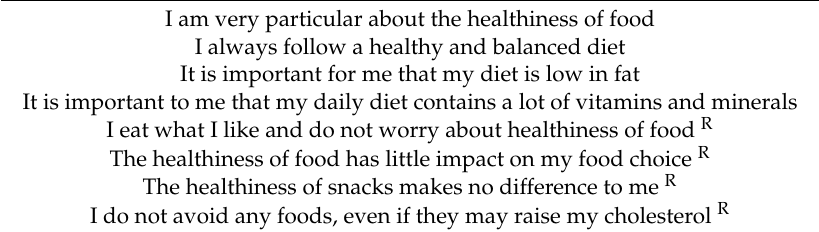
Table 2. Statements from the General Health Interest Scale